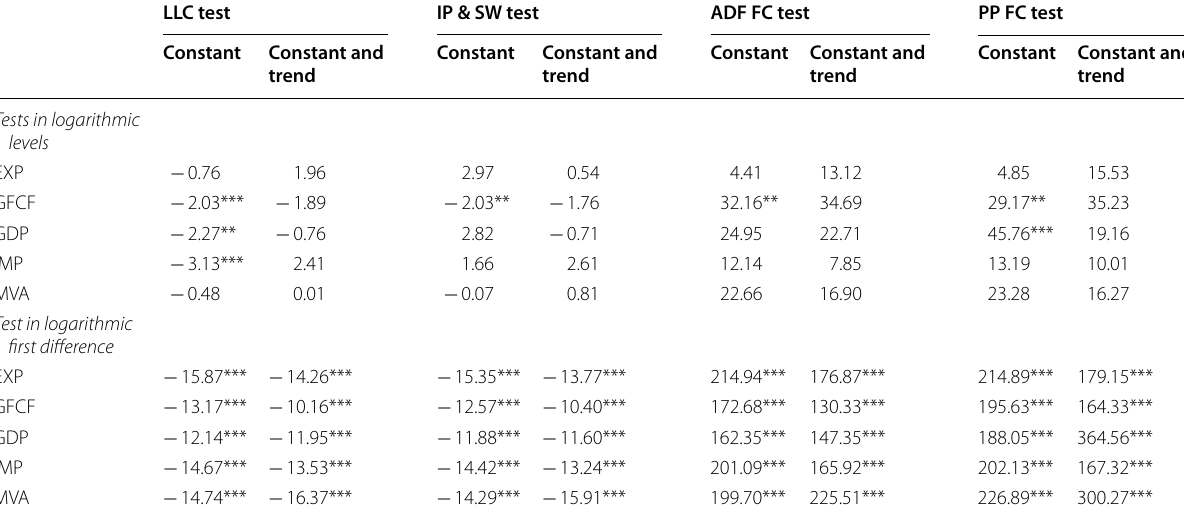
Table 1 Result of panel unit root test. Source : Computed from secondary